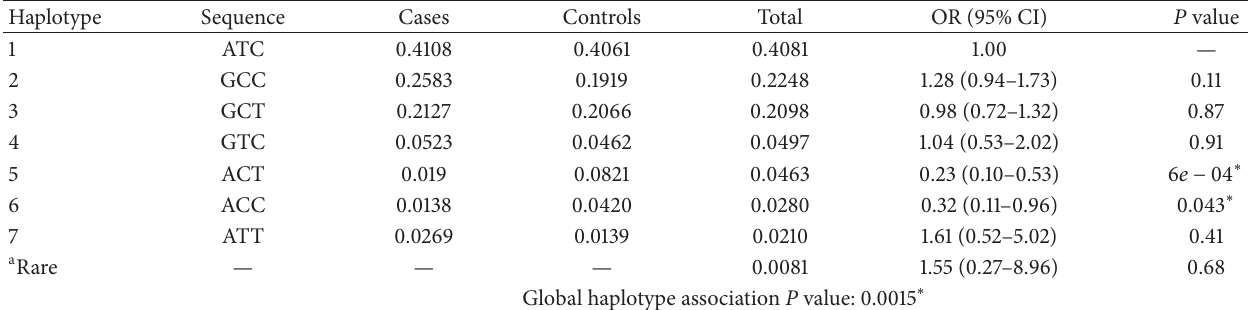
Table 4: Estimated haplotype frequencies and the association analysis with